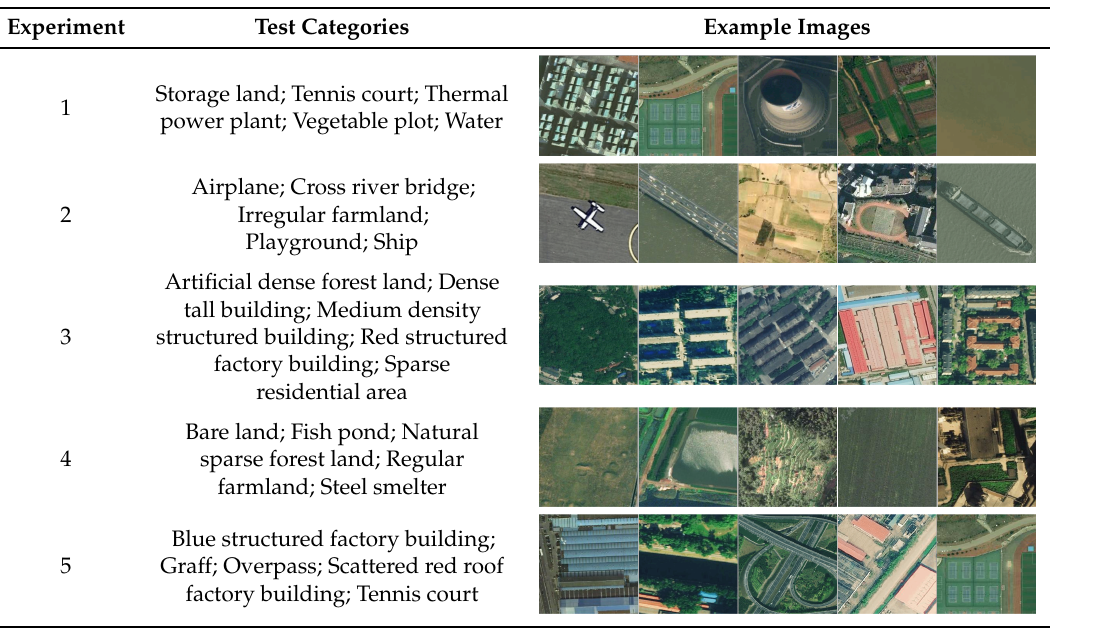
Table 3. Test categories and examples in each experiment on the RSD46-WHU dataset.